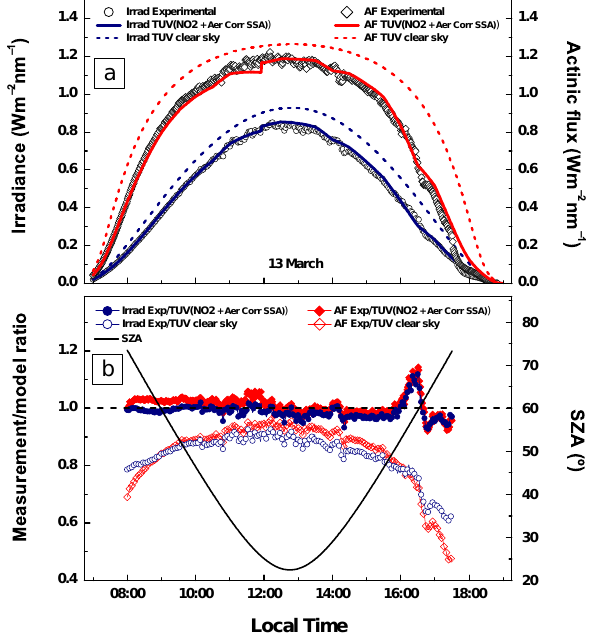
Fig. 4. (a) Daily course of the irradiance and actinic flux at 368nm for 13 March: measurements and model calculations (clear-sky and polluted). (b) The corresponding measurement/model ratios and the solar zenith angle (SZA) variation during this day. Dashed horizon- tal line corresponds to measurement/model ratio equal to